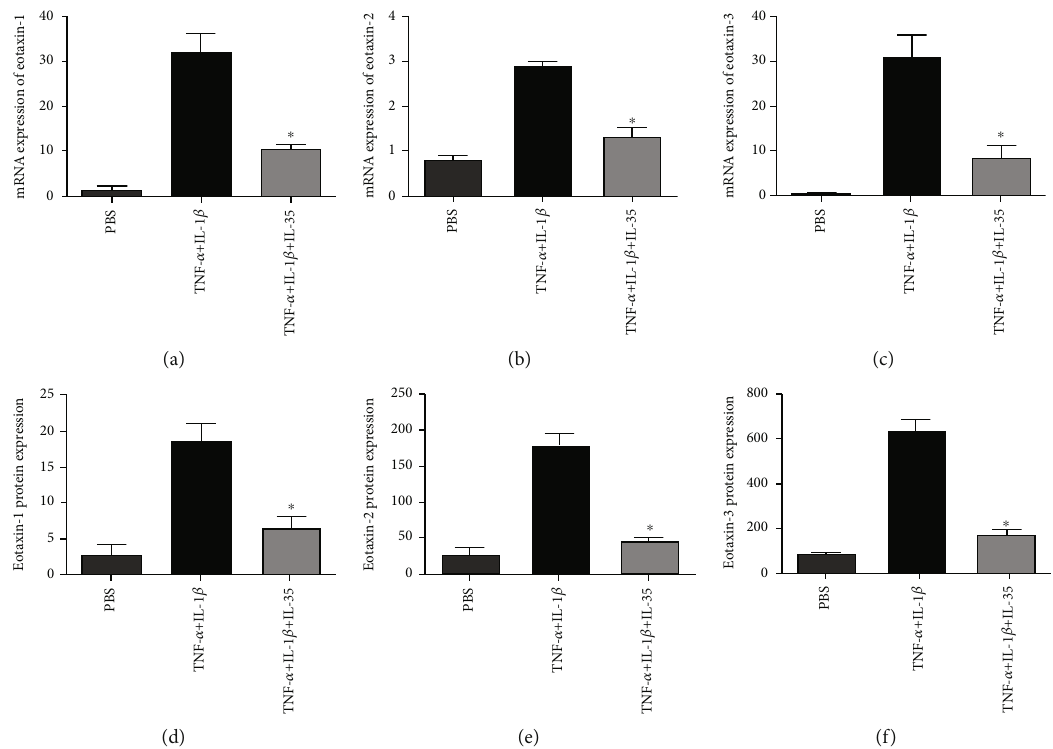
Figure 2: The expression of eotaxins by human nasal epithelial cells after various stimulators. (a – c) The mRNA expression of eotaxin-1, eotaxin-2, and eotaxin-3 by human nasal epithelial cells. (d – f) The protein expression of eotaxin-1, eotaxin-2, and eotaxin-3 by human nasal epithelial cells. Stimulators included 10ng/mL of TNF- α , 0.1 ng/mL of IL-1 β , and 100ng/mL interleukin-35. ∗ Compared with TNF- α +IL-1 β , P < 0 : 05 . Three independent tests were performed for every